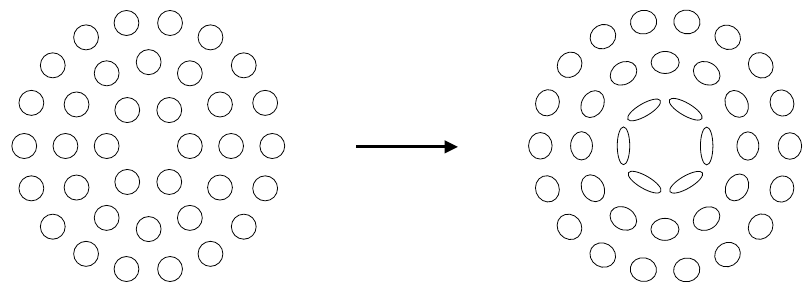
Figure 1 . We have zoomed in on the north pole. Initially circular rings are squeezed along (cid:18) and stretched along (cid:30) by the passage of the